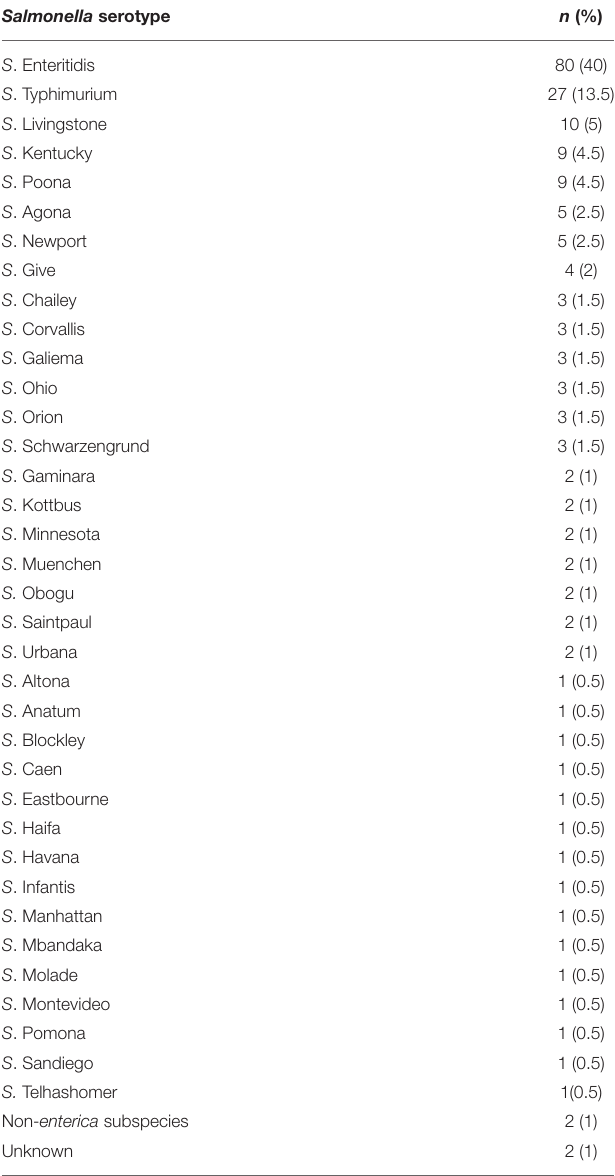
TABLE 2 | Prevalence of Salmonella serotypes associated with Human infections in Riyadh (2015–2017). Salmonella